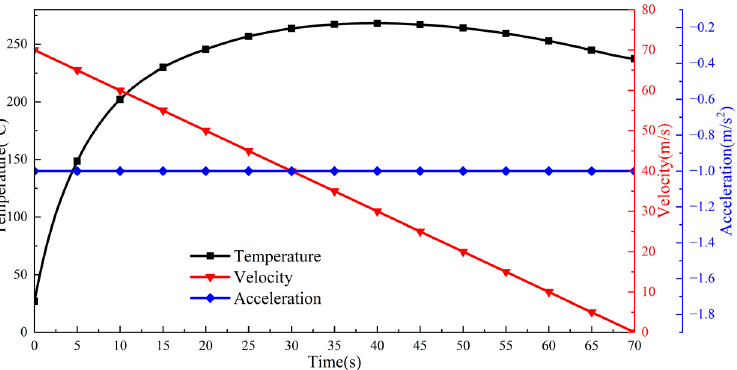
Figure 7. Maximum temperature, velocity, and acceleration time variation curves.